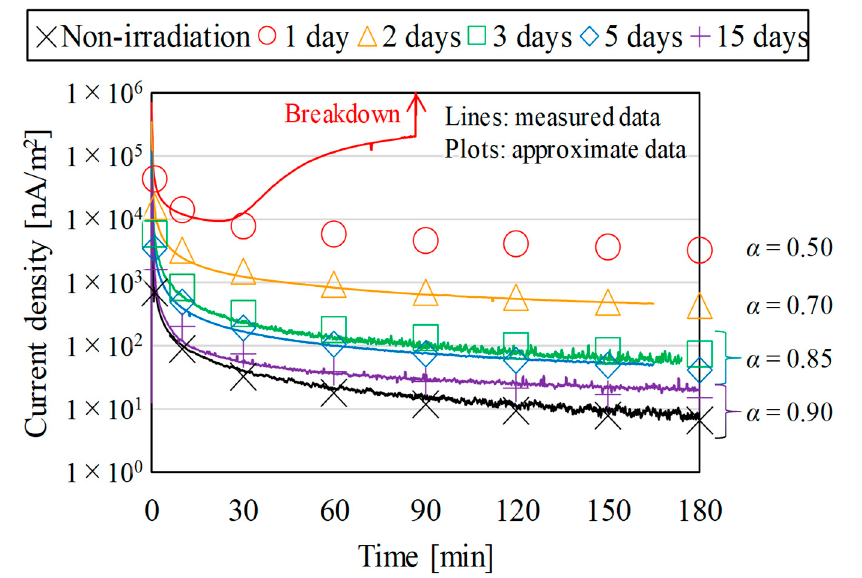
Figure 4. The change over time of the current density through the bulks of the proton irradiated samples under the irradiation energy condition of 2.0 MeV.